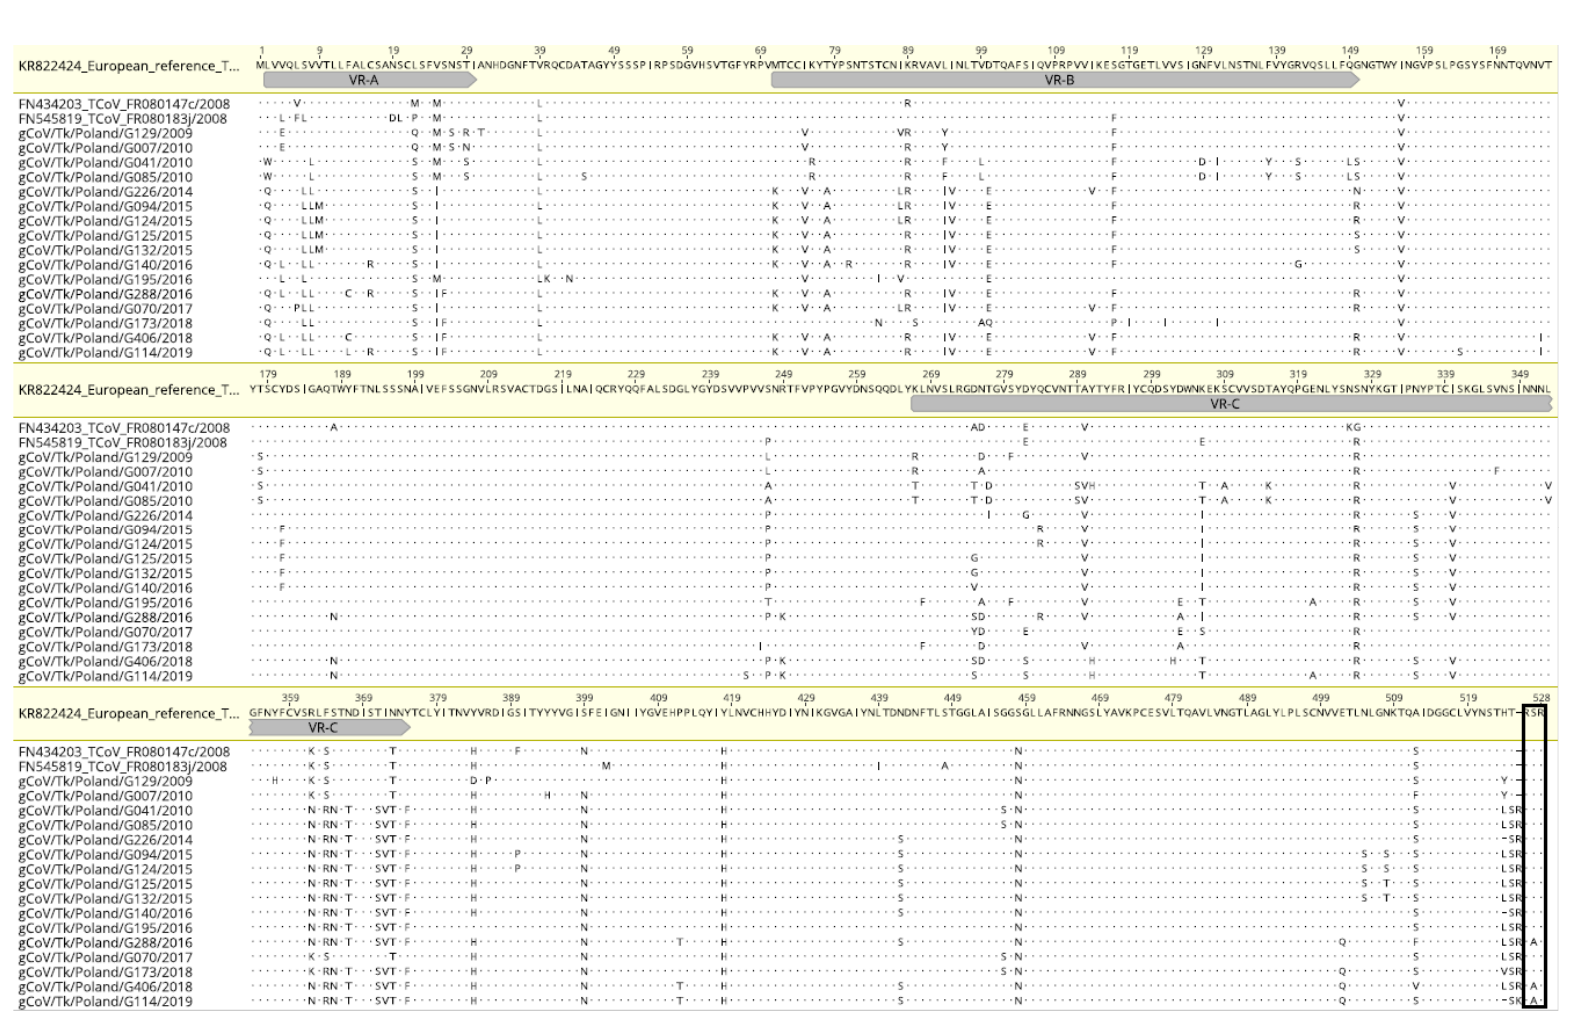
Figure 2. Amino acid alignment of the S1 subunit of Polish TCoVs and two other strains from France in comparison with European reference 080385d/France/2008 (KR822424) strain. Markings: dots—amino acids identical with the reference; gray bar beneath the reference strain—three variable regions (VR); box—putative cleavage site.